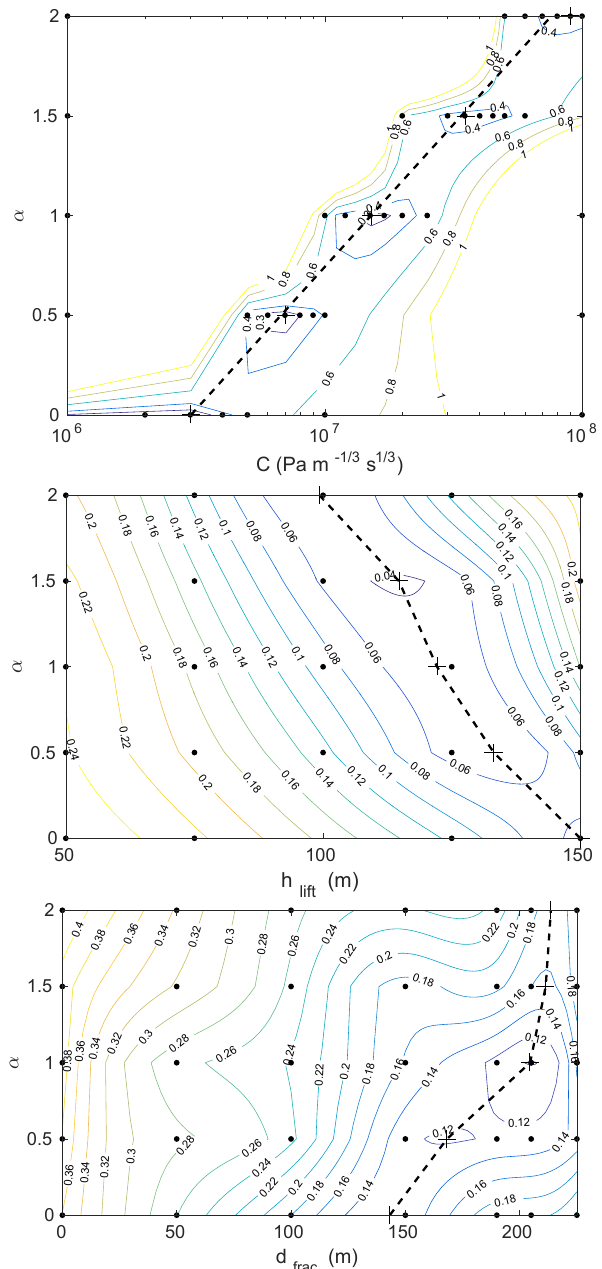
Figure 4. Level sets of the absolute misfit (in m per day) between modelled and measured surface velocity magnitudes as a function of the parameters α ( y axis), C ( x axis, upper panel), h lift ( x axis, middle panel) and d frac ( x axis, bottom panel). Each black dot cor- responds to one model realization from which the level sets were extrapolated. For each value of α , the symbol + displays the mini- mum with respect to C , h lift or d frac , while the dashed line connects the + symbols.